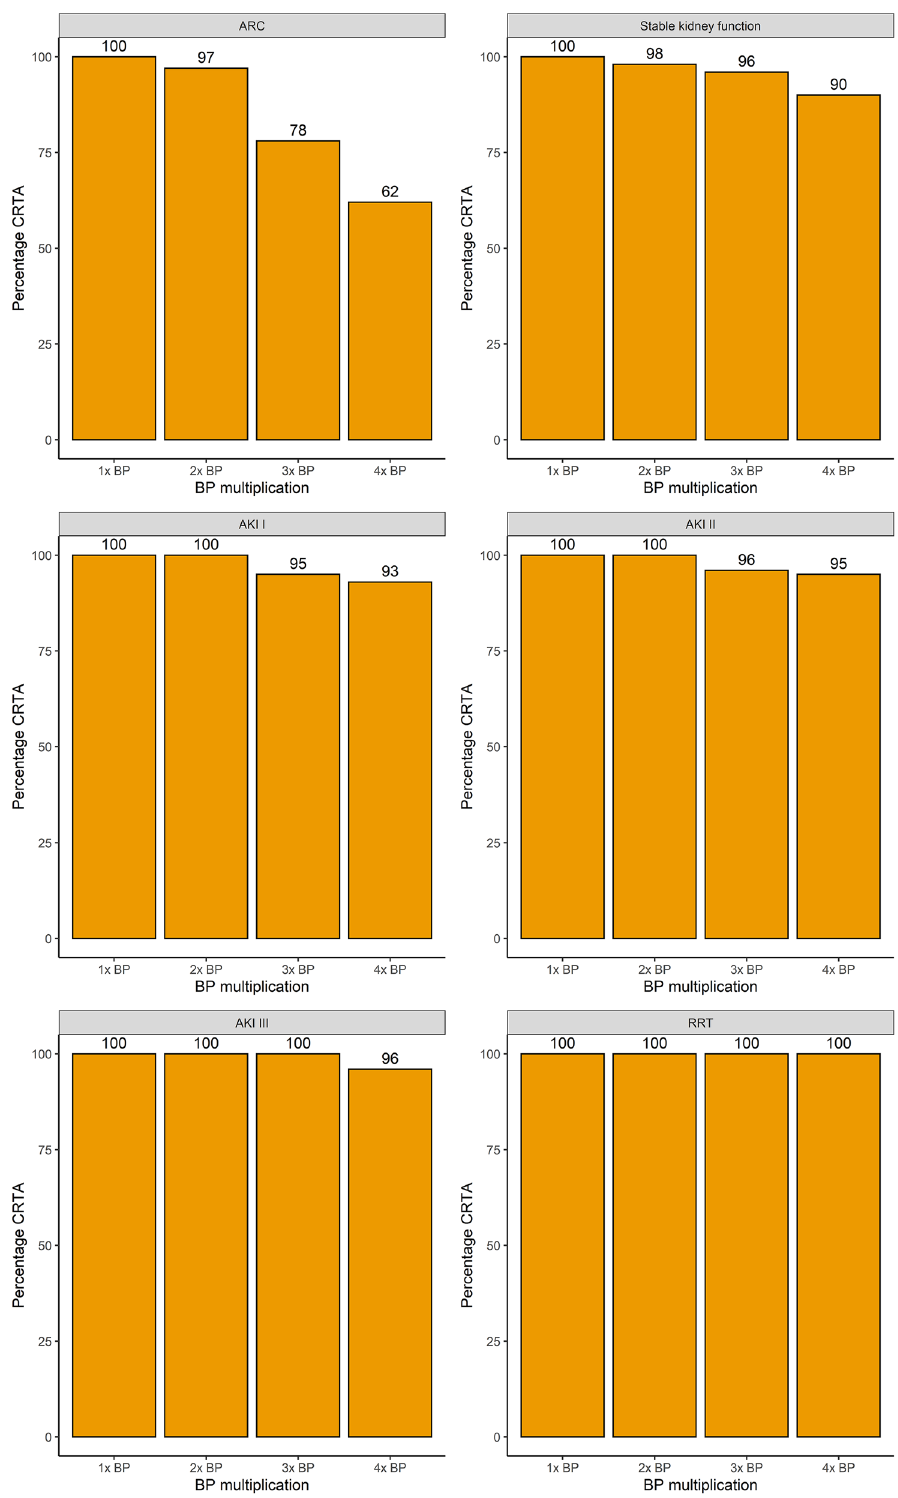
Fig. 8 Evolution of percentage of MEM CRTA according to kidney function for different BP